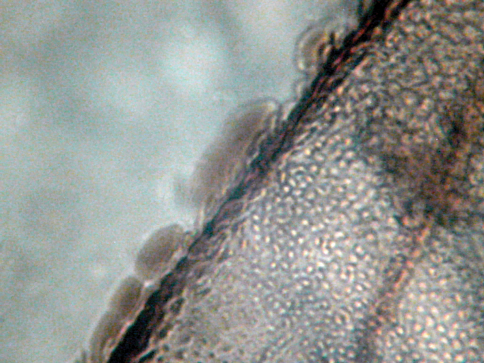
Microphotograph of structure of forewing margin.